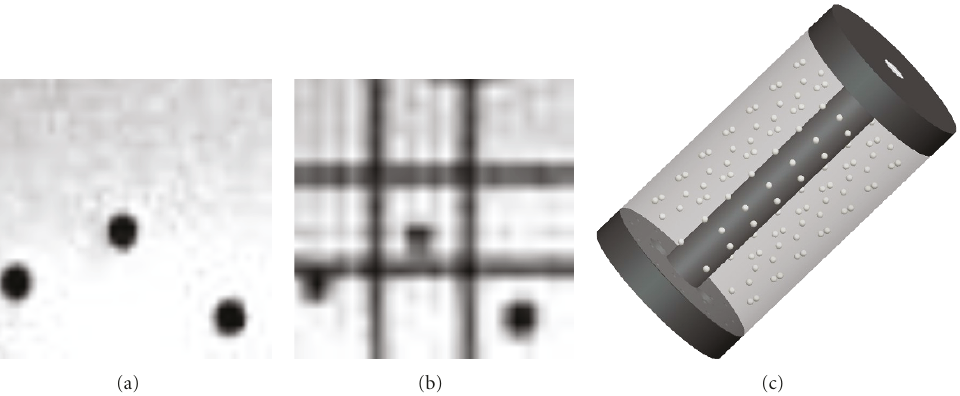
Figure 1: (a) An MR image of a gel region with markers, (b) a tagged MR image region, and (c) the silicone gel soft tissue phantom containing the spherical markers (white balls).